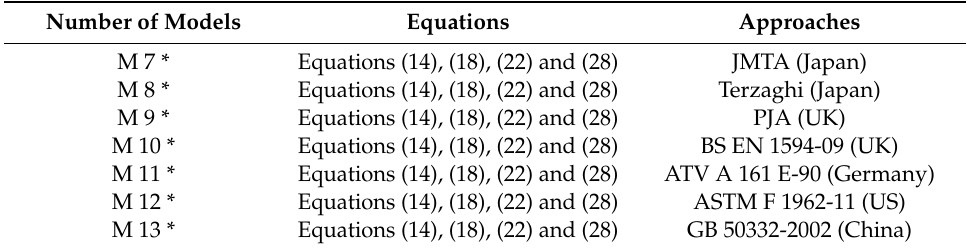
Table 3. The numbering of the new friction resistance prediction